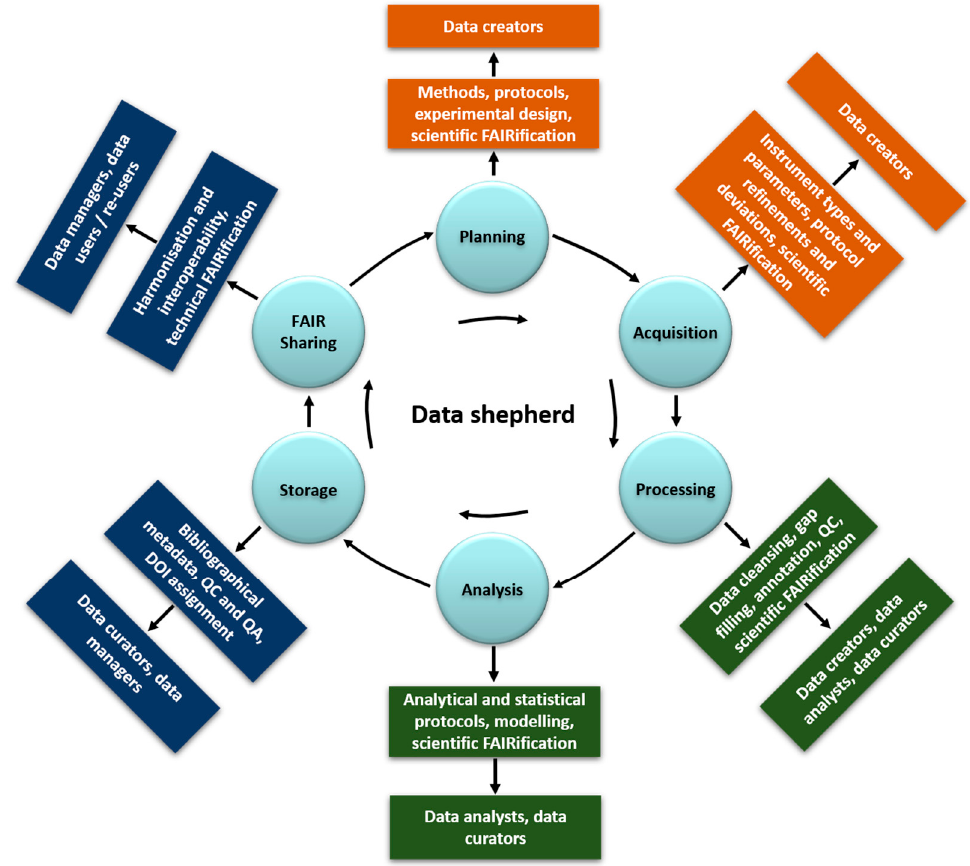
Figure 2. The data lifecycle, the metadata requirements at each stage, and the roles responsible for collecting and reporting the metadata at each step. The data shepherd exists to facilitate communication and streamline the entire workflow. (technical metadata = green, descriptive metadata = orange, bibliographical metadata = navy blue).